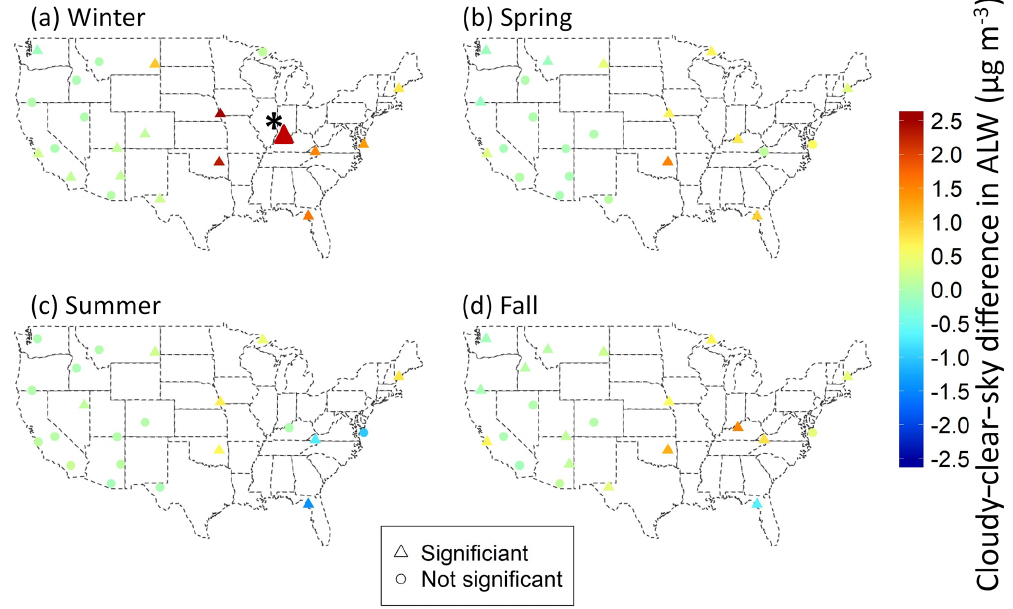
Figure A5. Maps of the difference in ALW mass concentration medians (cloudy–clear-sky) for all regions from 2010 to 2014 for (a) winter, (b) spring, (c) summer, and (d) fall. The color of the point corresponds to the magnitude of the difference. Triangles indicate that median differences are significant according to the Mann–Whitney U test. Note that the difference in wintertime medians for daily ALW concen- trations in the Ohio River Valley (denoted with an asterisk) is substantially larger than other regions (the cloudy median value is 4.6µgm − 3 larger than